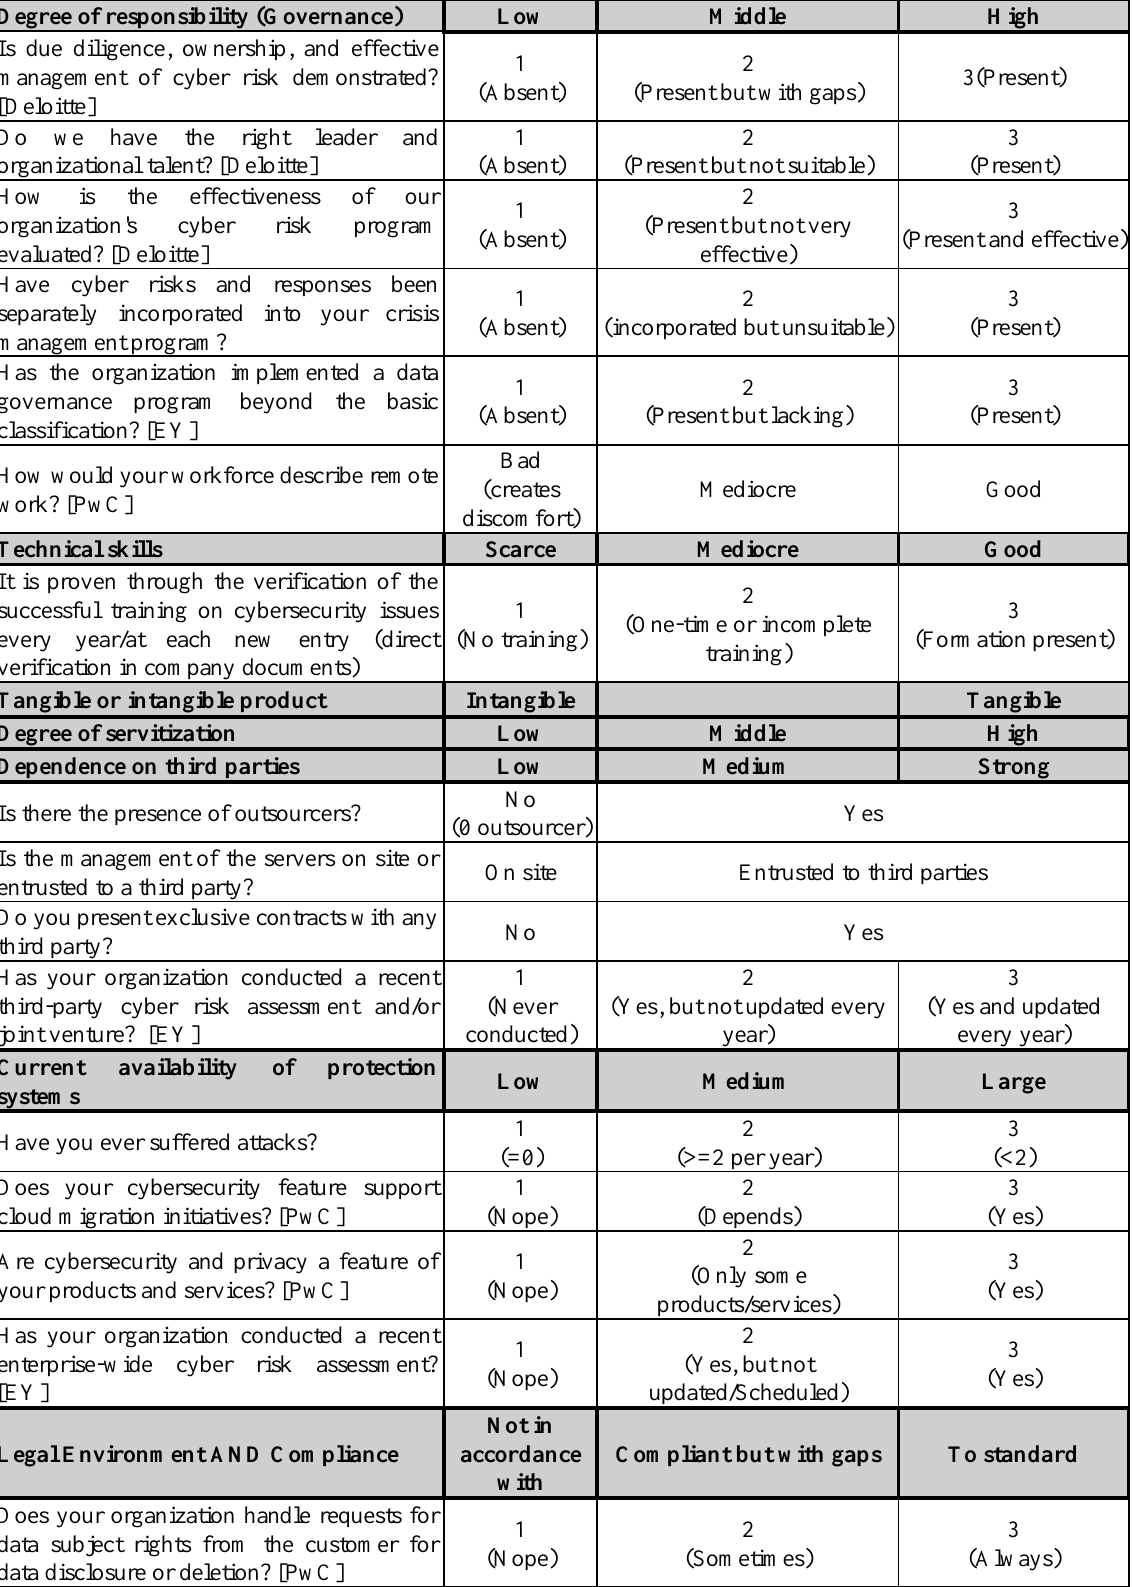
Table 3. The detailed content of the CyberSecurity Readiness Model for